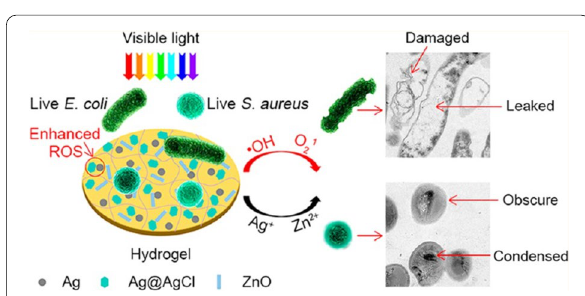
Fig. 9 Mechanism of Ag/Ag@AgCl/ZnO antibacterial. Adapted from Ref. [8] with permission. Copyright (2017) ACS Nano